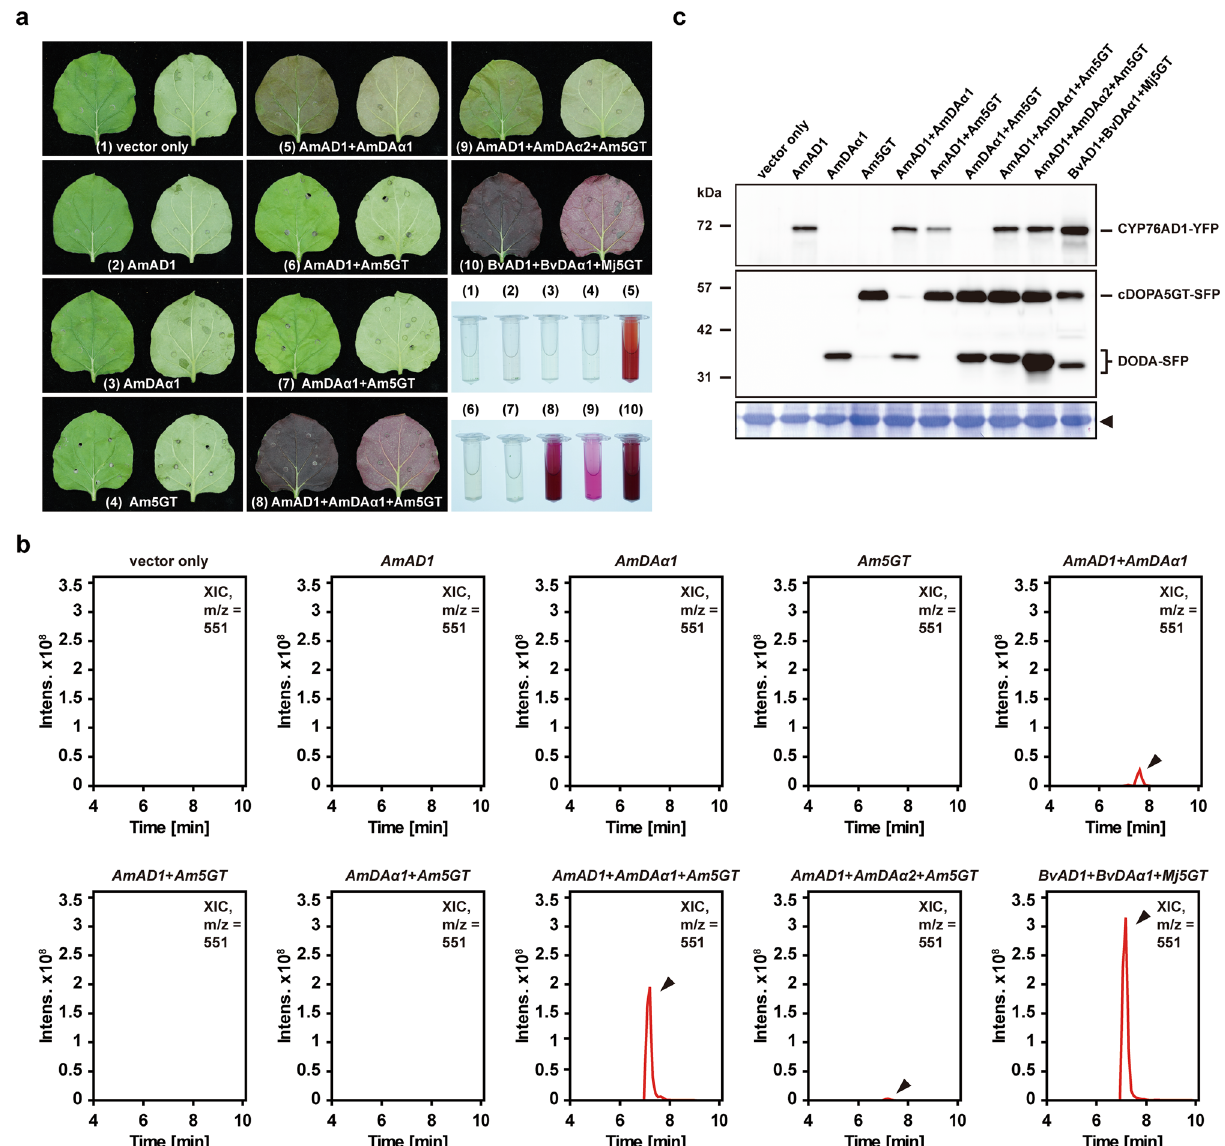
Figure 6. Reconstruction of the core betalain biosynthesis pathway of A. tricolor in N. benthamiana by agroinfiltration for the heterologous engineering of betalain pigments. ( a ) N. benthamiana leaves coinfiltrated with Agrobacterium harboring plasmids for the expression of BvCYP76AD1-YFP ( BvAD1 ), BvDODAα1-SFP ( BvDAα1 ), MjcDOPA5GT-SFP ( Mj5GT ), AmCYP76AD1-YFP ( AmAD1 ), AmDODAα1-SFP ( AmDAα1 ), AmDODAα2-SFP ( AmDAα2 ), and AmcDOPA5GT-SFP ( Am5GT ). Both the adaxial (left) and abaxial (right) sides of leaves are presented in each panel. Bottom right corner indicated the betalain pigments produced in N. benthamiana . ( b ) Extracted betalain pigments were examined for betanin content by LC–MS/MS analysis. Shown are XICs of masses corresponding to betanin (m/z = 551). Time, retention time (min). ( c ) Western blotting assays were conducted to examine the expression levels of YFP-tagged CYP76AD1 (upper panel), SFP- tagged DODA (middle panel), and SFP-tagged cDOPA5GT (middle panel) using antibodies against the YFP- or FLAG (SFP)-tag. As a loading control, the large subunit of Rubisco visualized with Coomassie brilliant blue staining is indicated by the arrowhead (lower